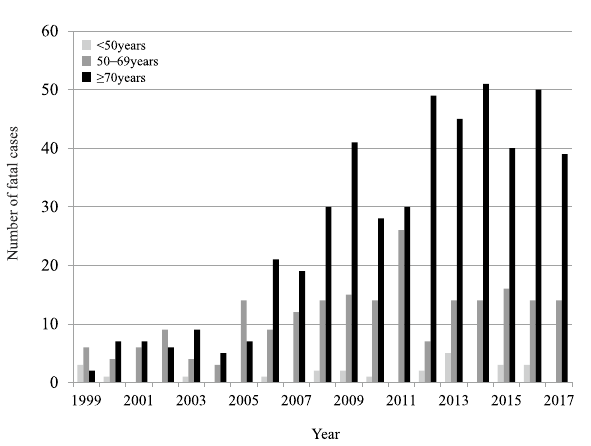
Figure 4. Incidence rates of legionellosis (a) crude incidence rates; (b) age-adjusted incidence rates; (c) trend analysis, 2013–2017. In the trend analysis, we calculated the annual percentage change in each of the 47 prefectures by joinpoint analysis.